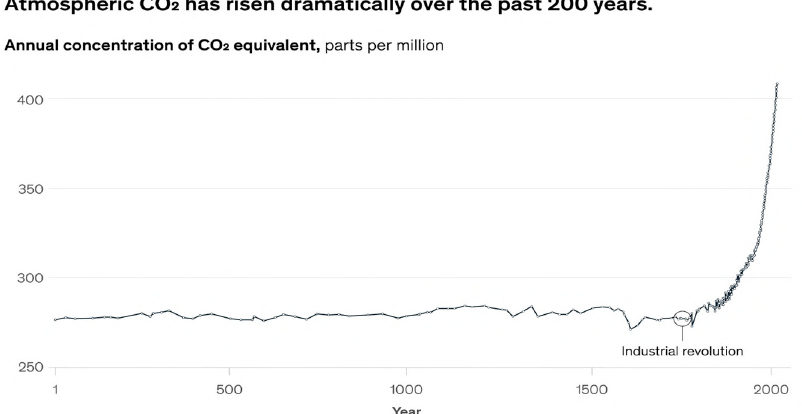
Figure 1. Atmospheric carbon dioxide concentrations during past and present years (Reprinted with permission from Doer and Narisetti (2021). 2021 McKinsey Global Publishing [4]).